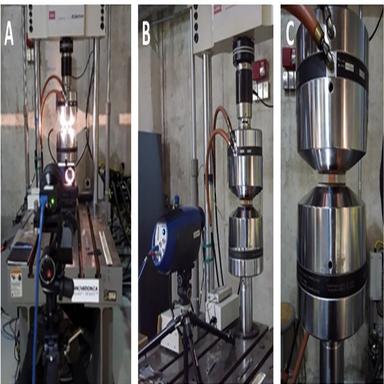
Test setups for compression. (A) DIC testing, (B) TSA testing, (C) Close-up of hydraulic grips for DIC, TSA, and conventional static and fatigue testing.